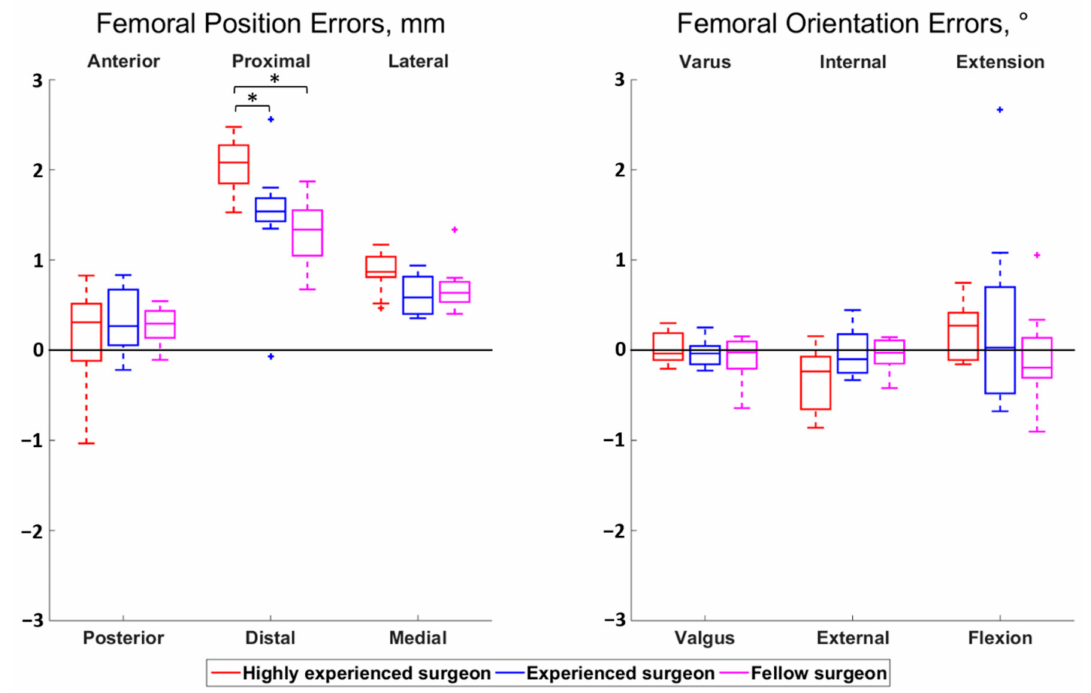
Figure 2. Boxplot of the position ( left ) and orientation ( right ) errors for the femoral cut. The direction at the top and bottom of the plots indicate where the actual cuts were compared to the planned cuts. For example, a positive anterior–posterior error indicates a cut that was too anterior compared to the planning. Statistically significant differences among surgeons are asterisked ( p < 0.05).